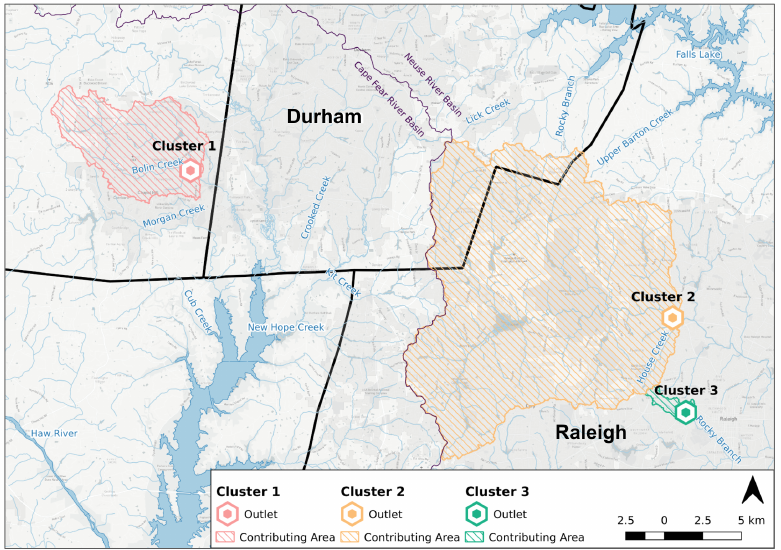
Figure 9. Three clusters representing stormwater problems in the Research Triangle, North Carolina, were identified from the spatial survey stakeholders completed during Workshop